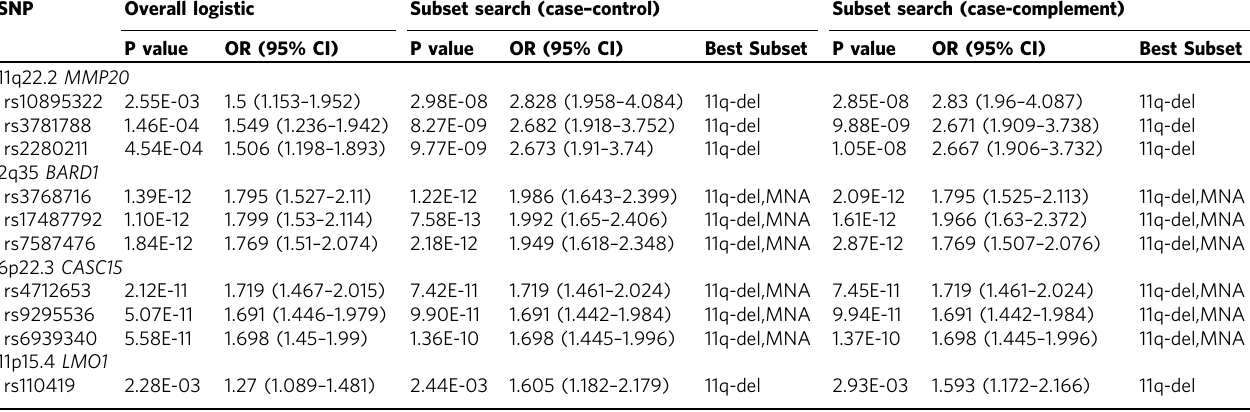
Table 2 Results from subtype analysis of neuroblastoma risk loci SNP Overall logistic Subset search (case – control) Subset search (case-complement)